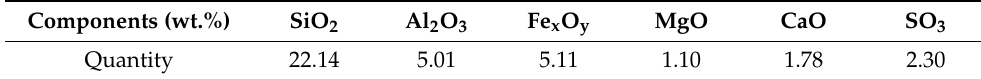
Table 1. Cement main components.